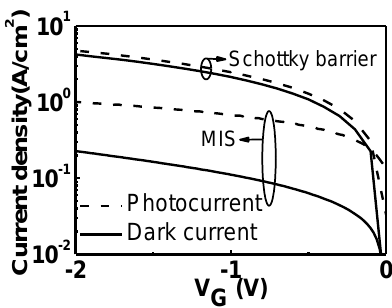
Figure 21. Dark currents and photocurrents of the 1.3  m thick-Ge GOI MIS and SB photodetectors. As compared with the SB detector, the MIS detector had a smaller dark current and a larger